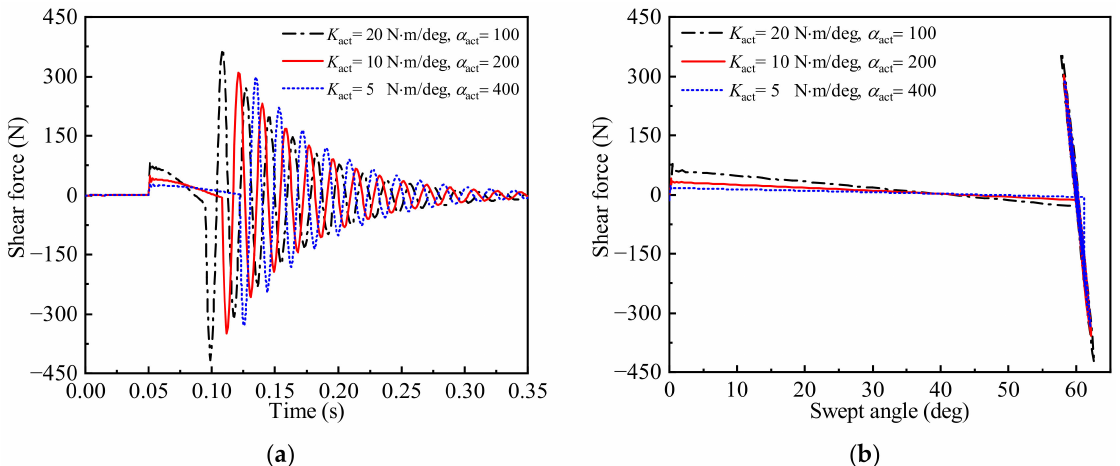
Figure 19. Transient responses of the wing root shear force. ( a ) Shear force vs. time. ( b ) Shear force vs. sweep